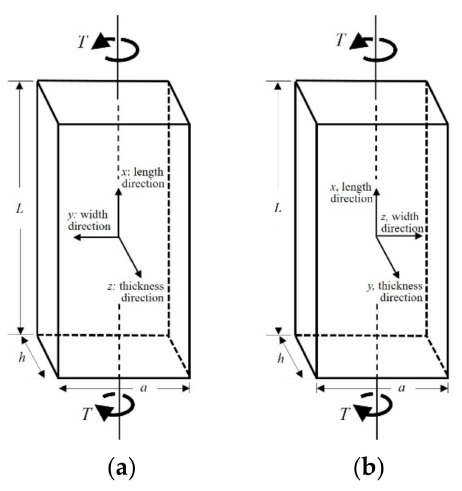
Figure 1. An isotropic rectangular prism under torsion and a 3-D Cartesian coordinate system ( a ) with y in the width direction and z in the thickness direction of the prism; ( b ) with y in the thickness direction and z in the width direction of the